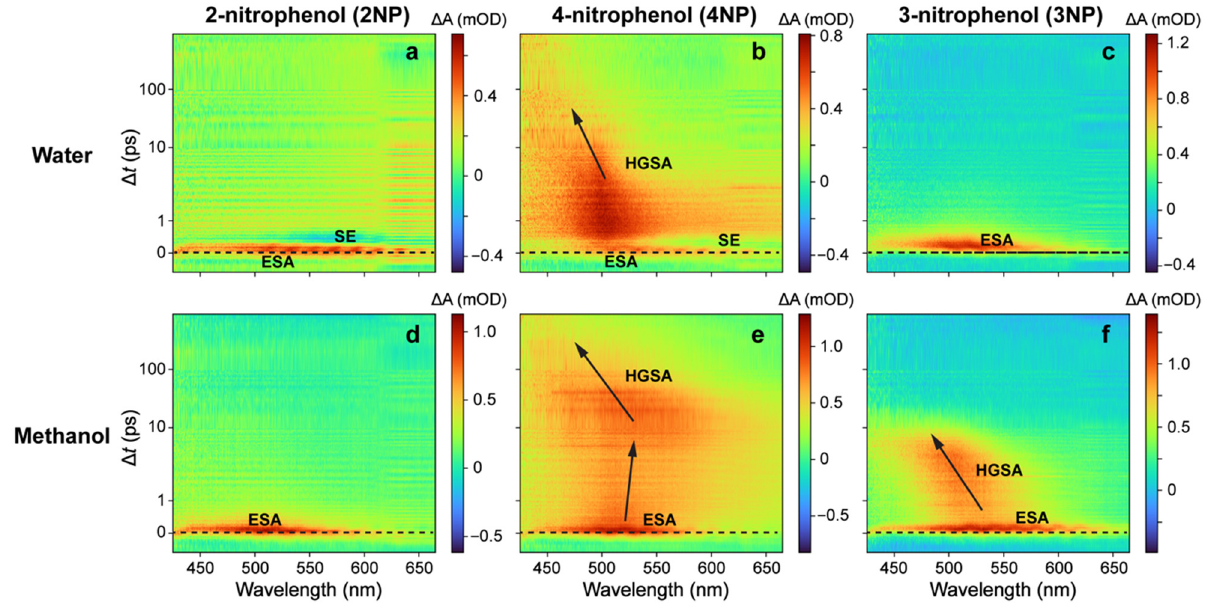
Figure 6. Semilogarithmic contour plots of fs-TA spectra of nitrophenols in water and methanol up to 900 ps after 267 nm excitation. The logarithmic scaling is for time points after 1 ps. The spectra of ( a ) 2NP, ( b ) 4NP, and ( c ) 3NP in water are compared with the spectra of ( d ) 2NP, ( e ) 4NP, and ( f ) 3NP in methanol. Key spectral features are labeled in black, with black arrows highlighting prominent peak shifts within the detection time window. Weak spectral features can be better seen in the probe-dependent fits and global analysis plots. For the methanol data, the spectra shown have an average of five pre-excitation spectra subtracted to remove the nonzero background before the actinic pump (see Figure S5). Table 3. Lifetimes and associated states from global analysis of the nitrophenol fs-TA spectra in Figure